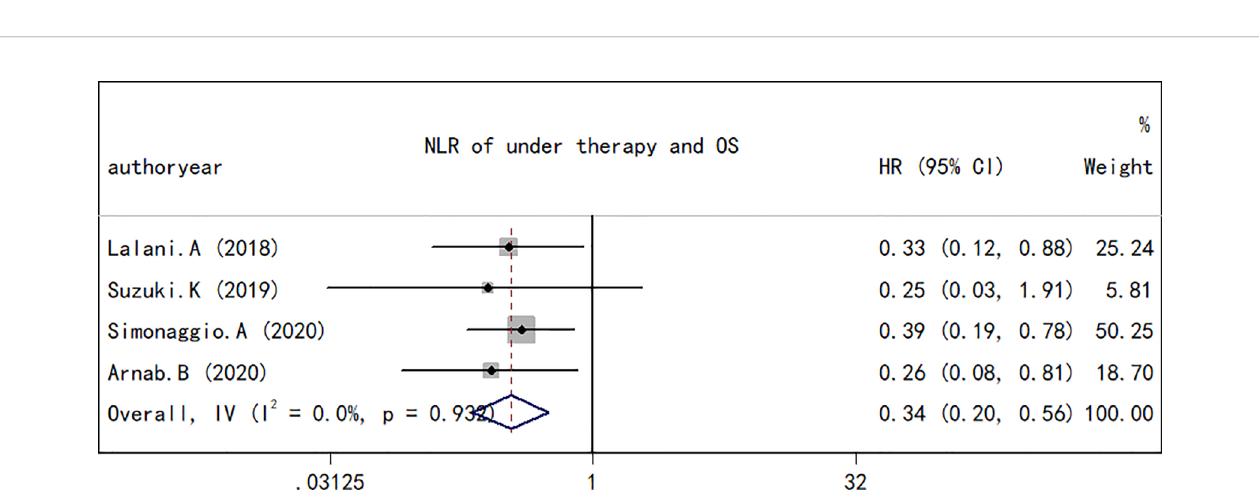
FIGURE 2 | Forest plot of hazard ratios for the association between the neutrophil-to-lymphocyte ratio at baseline or pre-therapy and overall survival in renal cell carcinoma.